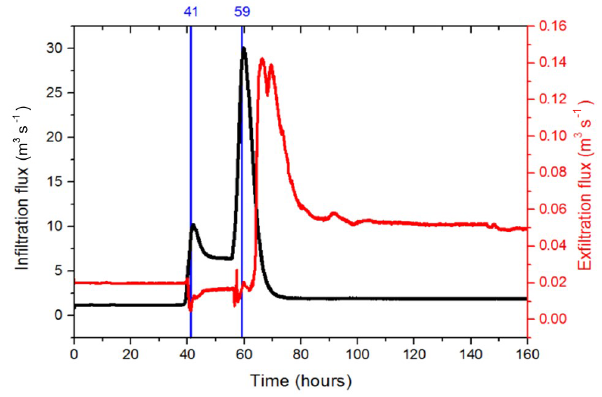
Figure 10. Evolution of the infiltration and exfiltration volumetric fluxes during the first steps of the calibration period (where evolu- tions are